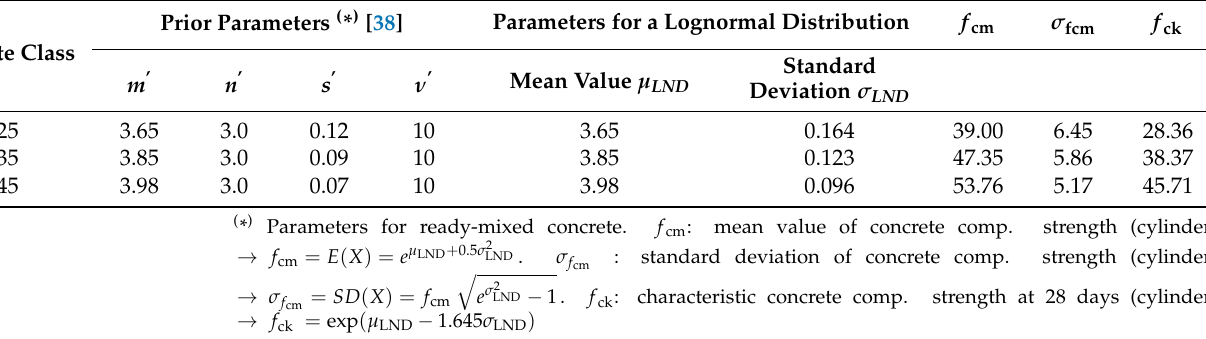
Table 1. Stochastic values for the concrete compressive strength f c